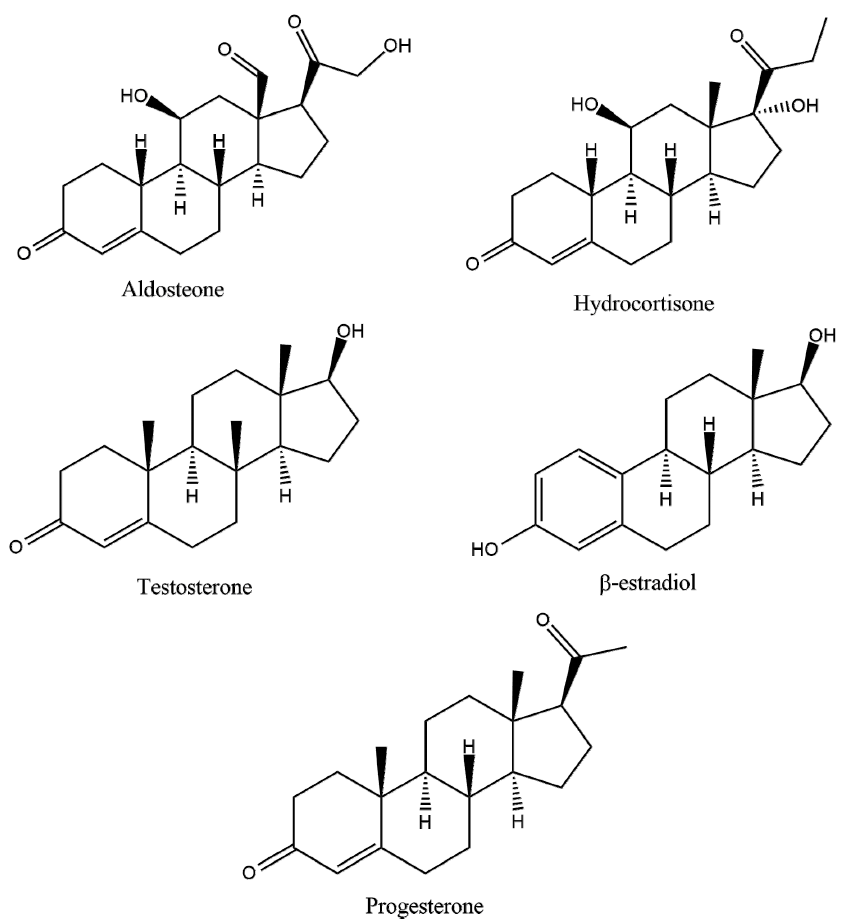
Figure 1. Chemical structures of hormone group representatives.